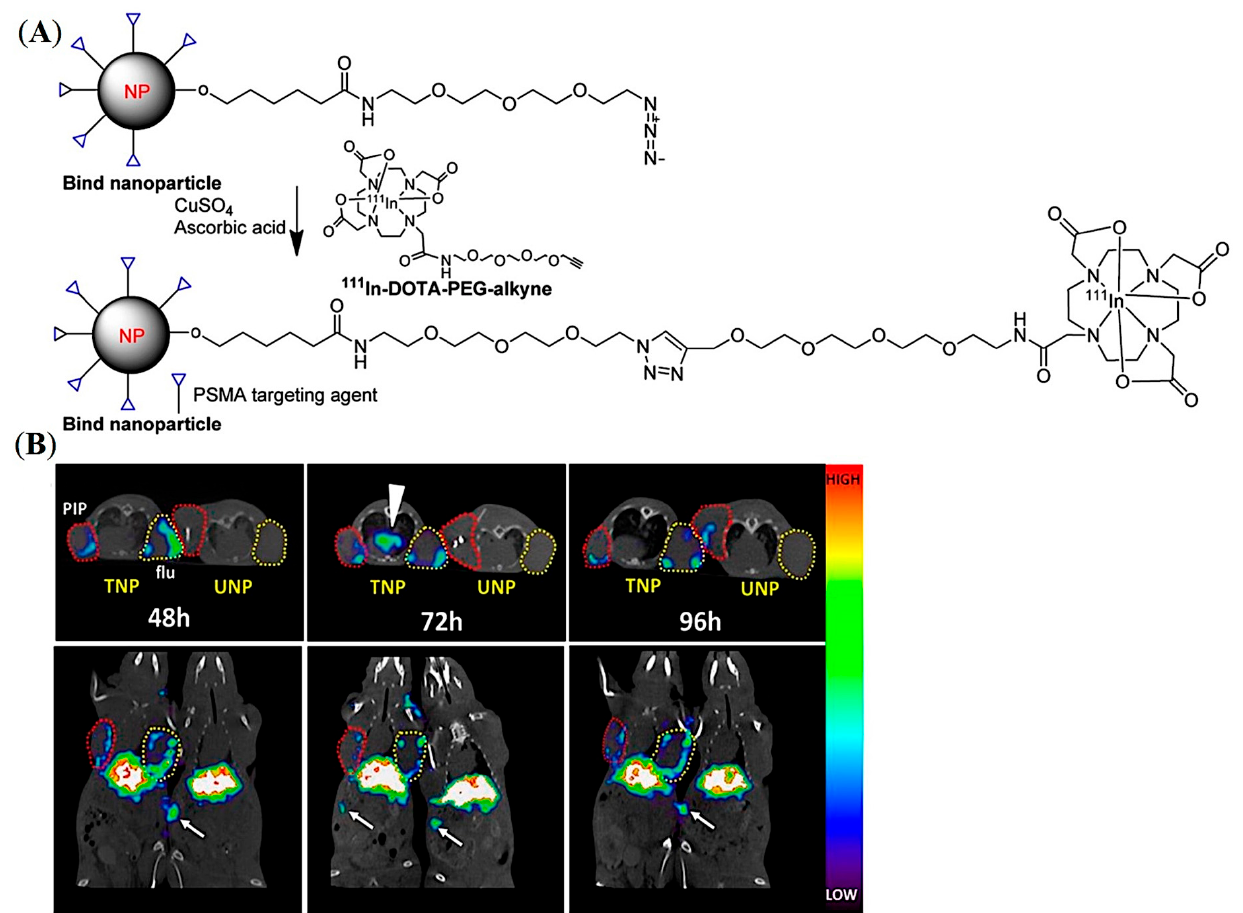
Figure 6. Development of PSMA-targeted PLA-PEG NPs for imaging of prostate cancer in mouse models. ( A ) Representative structure of the PSMA-targeted PLA-PEG NPs. ( B ) In vivo SPECT-CT of 111 In-labelled PSMA-targeted and non-targeted NPs in PSMA expressing PC3-Pip (red circles) and PSMA negative PC3-Flu (yellow circles) tumor-bearing mice model up to 96 h. White arrows show prominent spleen uptake. Reprinted with permission from Ref [51]. Copyright 2017, American Chemical Society.